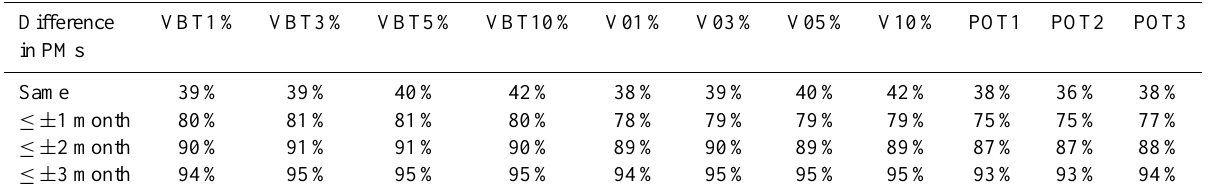
Table 3. Percentage of stations according to the difference in PMs between modeled and observed streamflow at each classification technique. Difference